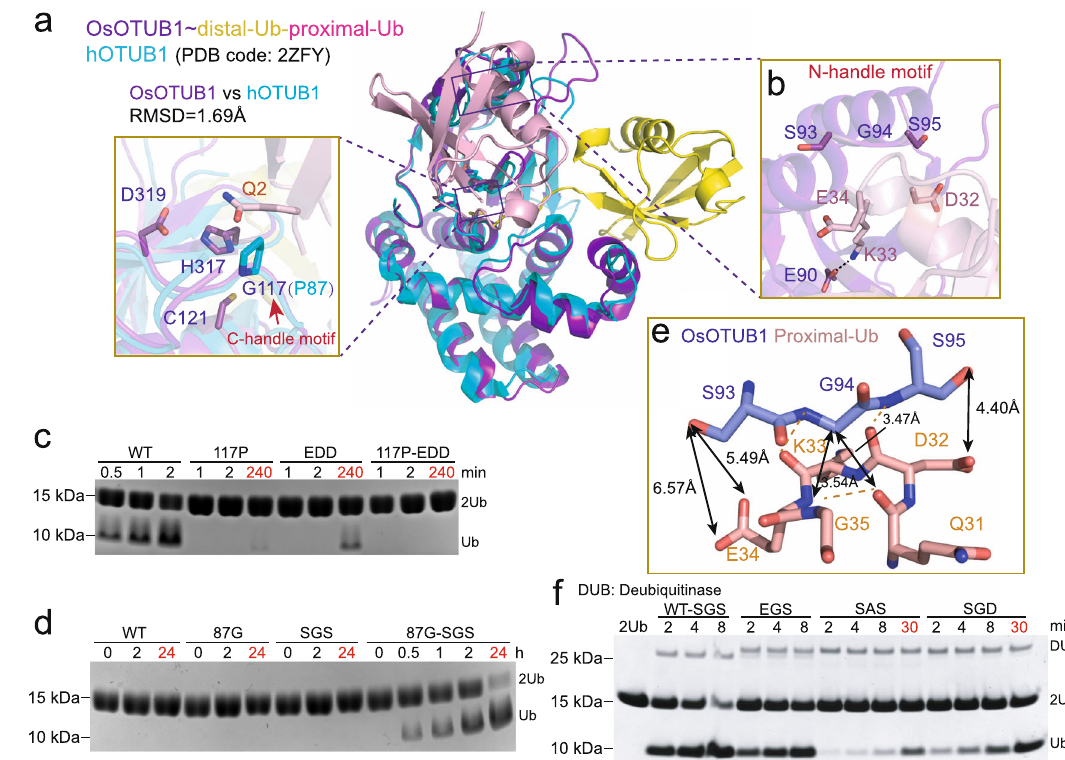
Fig.3|TwomotifsinS1 ’ pocketdetermineMet1linkageselectivityofOsOTUB1. a Structural alignment between C-handle motifs of OsOTUB1-cat~Met1-diUb-DHA and hOTUB1-cat; b Structural alignment between N-handle motifs of OsOTUB1- cat~Met1-diUb-DHA and hOTUB1-cat; c Effects of mutations in two motifs on the hydrolysis activity of OsOTUB1-cat against Met1-diUb ( N =3 biologically indepen- dentexperiments); d Effectsofmutationsintwomotifsonthehydrolysisactivityof